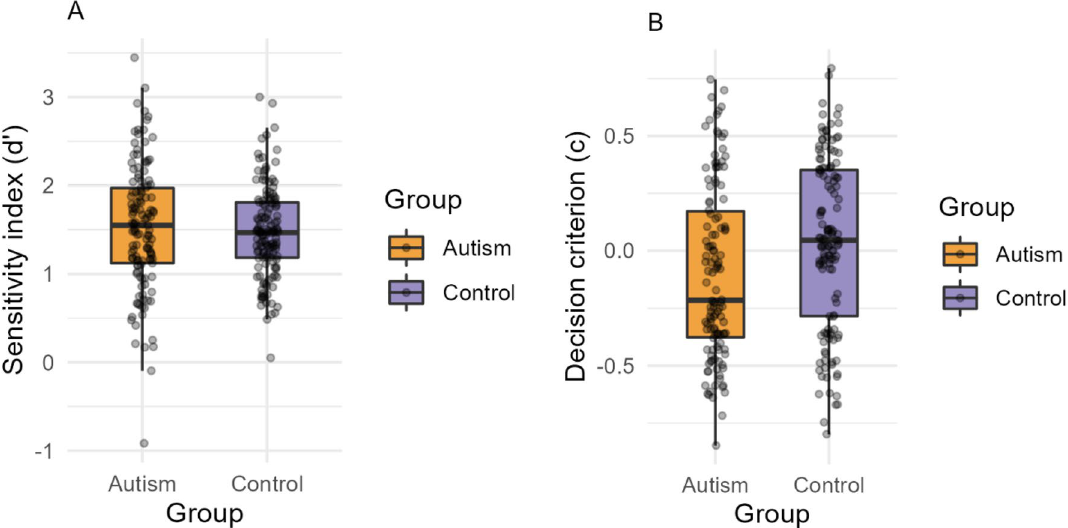
Figure 2. Task 1: Interlocking polygons. ( A ) Signal detection sensitivity index for autism and control groups. ( B ) Signal detection decision criterion values for autism and control groups. Autism group is displayed in orange and control in purple. Dots indicate individual participant results. Error bars show the standard error of the mean.